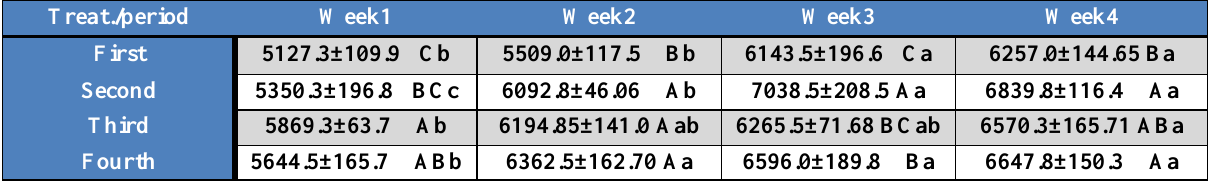
Different small letters showed significant difference among periods at the level of (P < 0.05). Different capital letters showed significant difference among treatments at the level of (P <